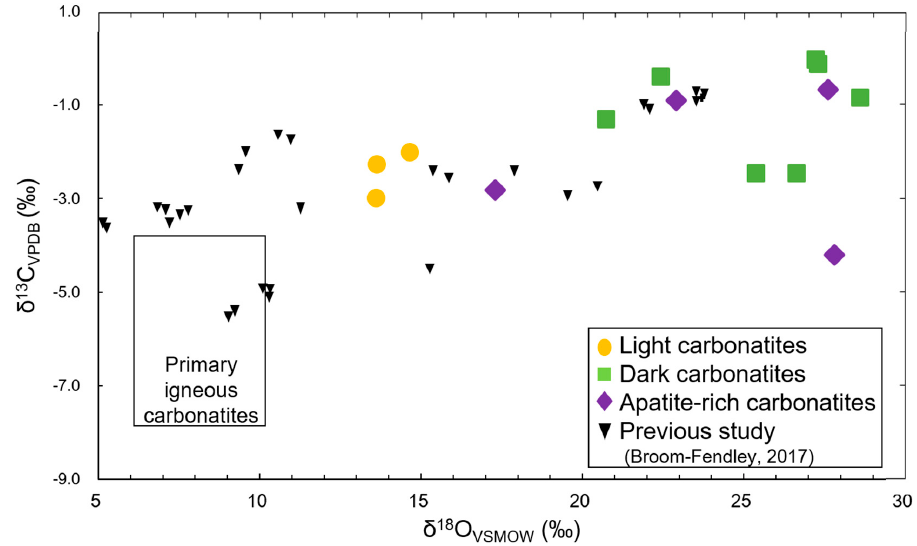
Figure 9. Whole-rock δ 13 C and δ 18 O compositions of the Kangankunde carbonatites compared with those in a pvevious study [5]. Compositional fields are shown for primary igneous carbonatites [29].